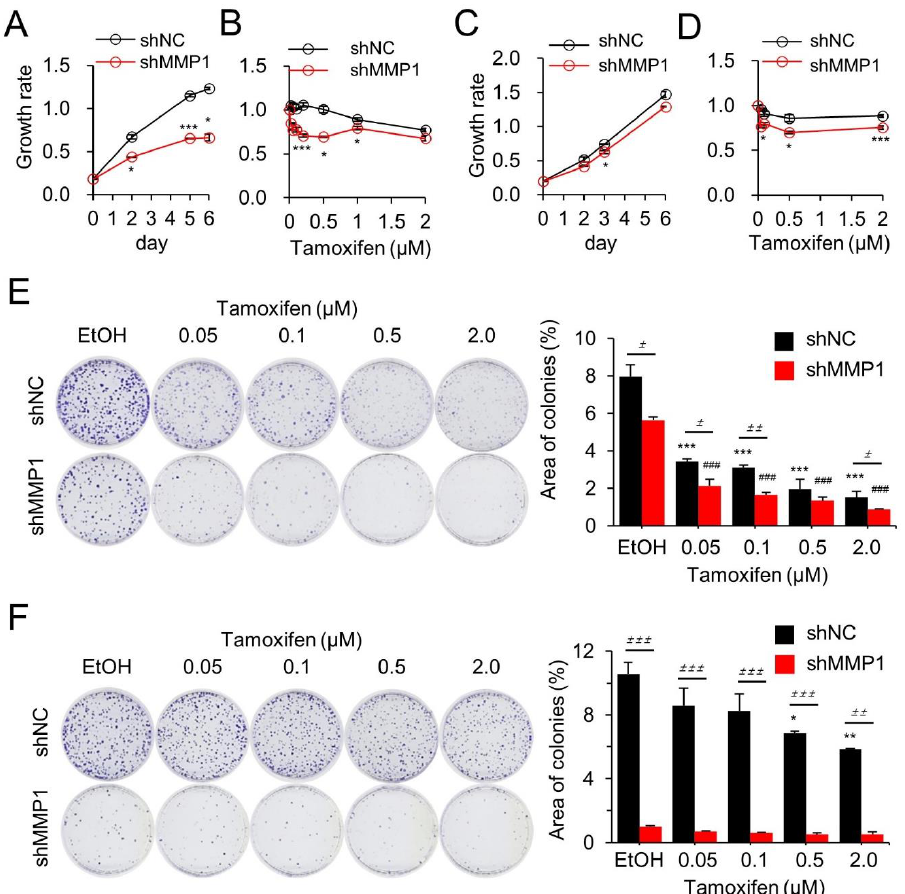
Figure 2. MMP1 promotes cell growth and confers tam resistance in MCF-7 and MCF-7/tamR cells. MMP1 was downregulated by injecting a stably expressed shRNA lentiviral vector into MCF-7 and MCF-7/tamR cells. Effects of MMP1 on cell growth ( A , C ) and tam sensitivity ( B , D ) were examined by colorimetric analysis using the CCK-8 reagent in MCF-7/tamR ( A , B ) and MCF-7 cells ( C , D ). Effects of MMP1 on tam sensitivity were confirmed by the colony formation assay for MCF-7 ( E ) and MCF-7/tamR cells ( F ). All assays were performed in three independent experiments. Data are presented as mean ± SE. The values at each day of culture were compared to assess statistical significance in ( A − D) . Representative images are shown for the colony formation assay. shMMP1, short hairpin RNA against MMP1; shNC, negative control shRNA. * p < 0.05, ** p < 0.01, and *** p < 0.001 versus shNC control; ### p < 0.005 versus shMMP1 control; ± p < 0.05, ±± p < 0.01, ±±± p < 0.005.